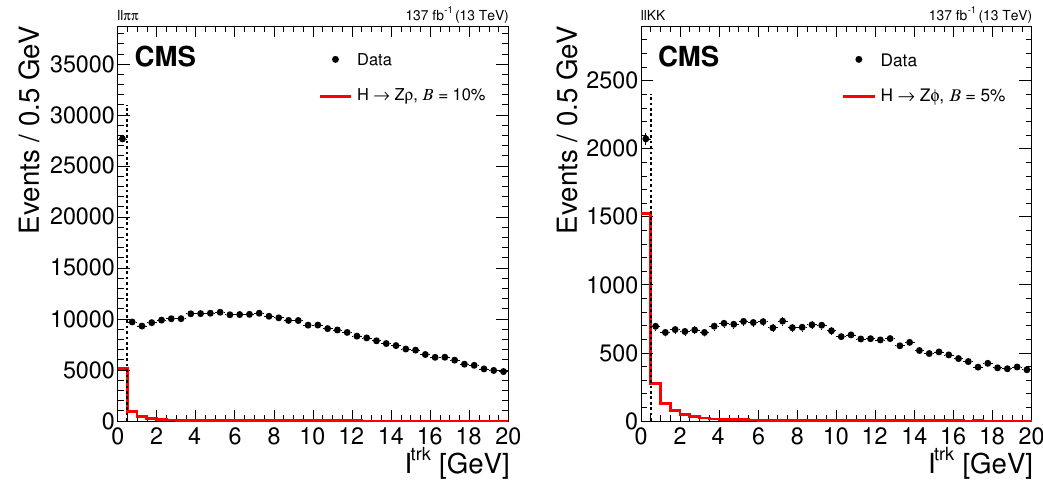
Figure 4 . The ditrack isolation sum in the ‘‘ (cid:25)(cid:25) (left) and ‘‘ KK (right) channels, combining the (cid:22)(cid:22) and ee channels for all the data-taking years. The distribution in data, as well as in the simulated H → Z (cid:26) and H → Z (cid:30) signals is shown. A branching fraction of 10 (5)% for the H → Z (cid:26) ( H → Z (cid:30) ) signal is assumed. The isolation sum is shown after applying all selection criteria apart from the ditrack isolation requirement. The ditrack invariant mass requirement is also applied. Only events in which the dilepton plus ditrack invariant mass is in the range 120–130 GeV are considered. The dashed line indicates the boundary of the region used in the analysis, for which the isolation sum is required to be smaller than 0.5